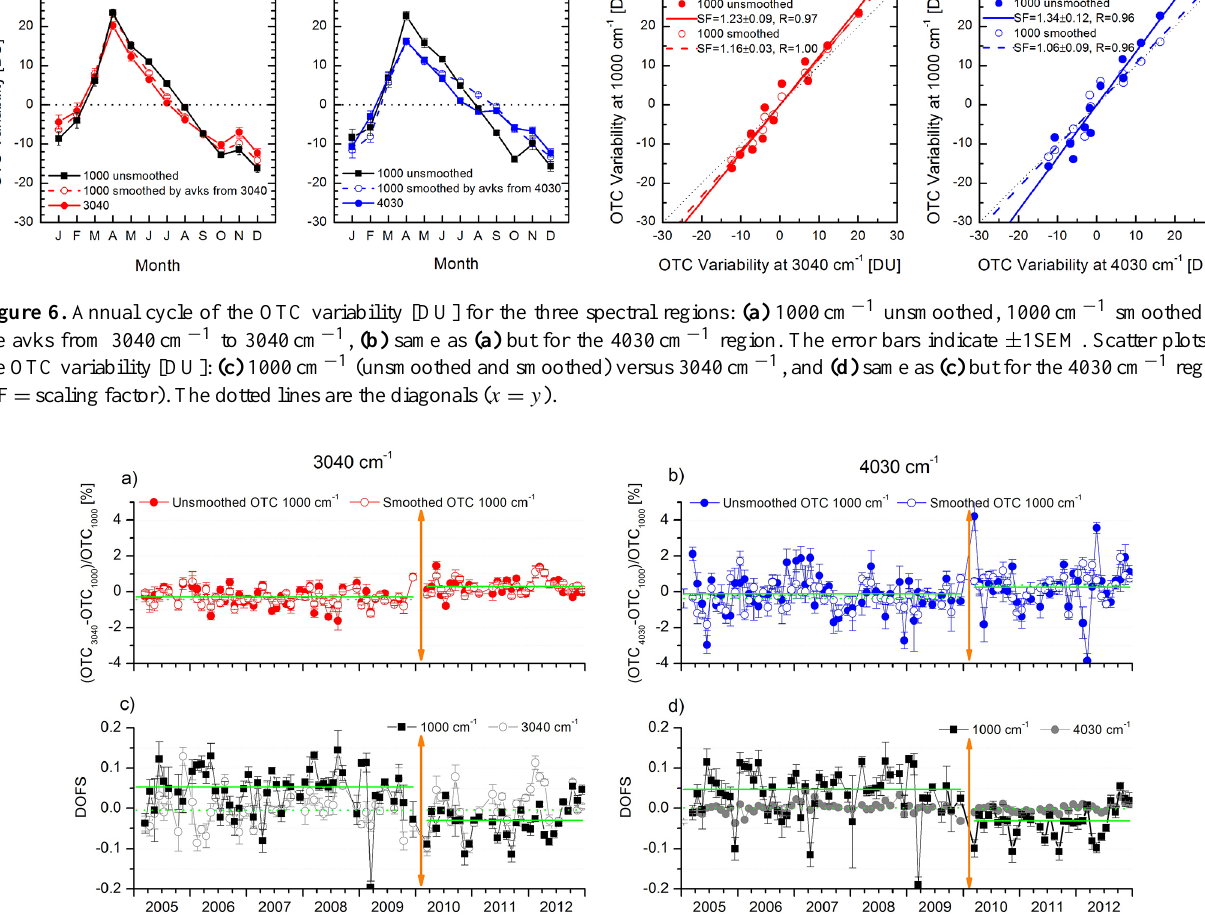
Figure 7. Time series of the deseasonalised monthly relative differences with respect to the 1000cm − 1 OTC ( a , 3040cm − 1 and b , 4030cm − 1 ). The solid and dashed green lines represents the medians of the relative difference time series for the unsmoothed and smoothed 1000cm − 1 OTC, respectively. These medians are calculated for the periods before and after the systematic change point detected in December 2009 (solid orange line). (c) and (d) same as (a) and (b) , but for the deseasonalised monthly DOFS time series. The solid green lines represents the medians of the DOFS time series for the 1000cm − 1 OTC and the dashed ones are for 3040 and 4030cm − 1